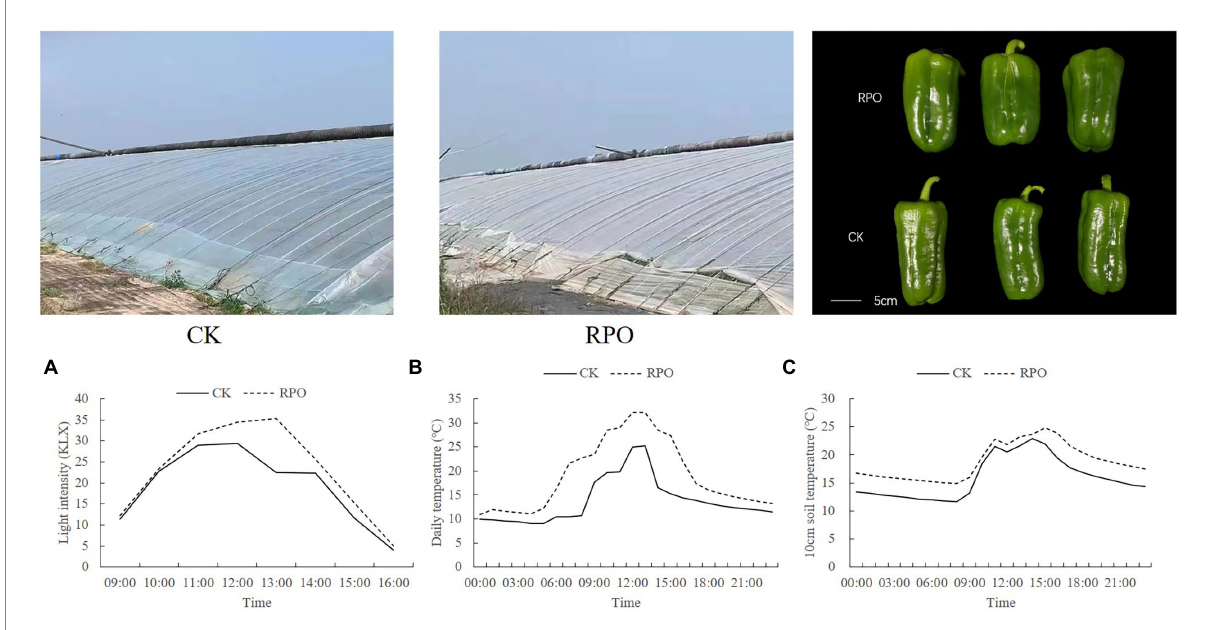
FIGURE 1 Effects of RPO film on the changes of sunlight intensity and temperature in the greenhouse. (A) Daily variation of light intensity; (B) air temperature and (C) soil (10 cm soil layer)